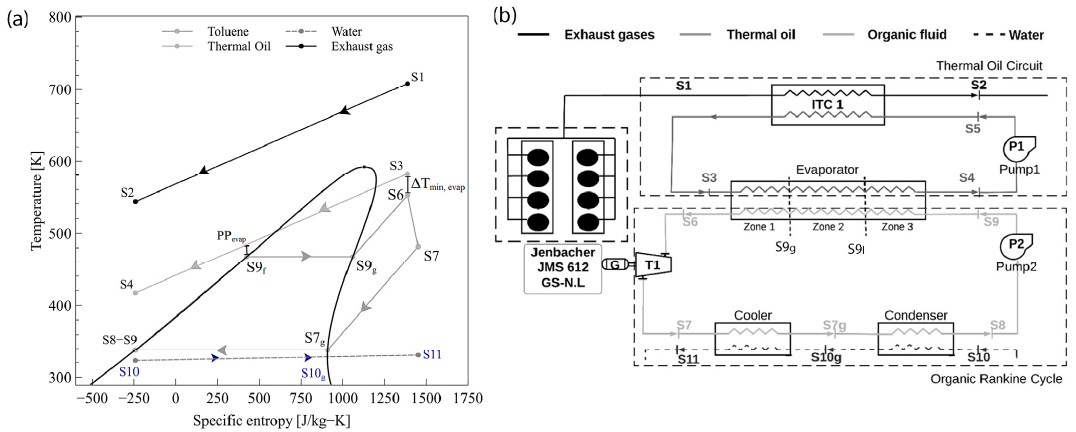
Figure 1. Scheme proposed ( a ) T − S diagram, ( b ) Waste heat recovery system. The exhaust gas stream came from an industrial internal combustion engine (Jen- bacher JMS 612 GS-N.L). The fuel composition consisted of methane (97.97%), nitrogen (1.50%), ethane (0.25%), and carbon dioxide (0.16%). The fuel uncorrected volume ratio is between 110–149 L/s. The composition of the exhaust gas was: O 2 (9.45–10.52% v / v ), CO (588–731 mg/m 3 ), NO x (461–468 mg/m 3 ), NO 2 (317–368 mg/m 3 ), and NO (65–95 mg/m 3 ). The exhaust gas temperature is between 420–460 °C. The main operating parameters of the engine are shown in Table 1. Table 1. Main engine characteristics. Descriptions